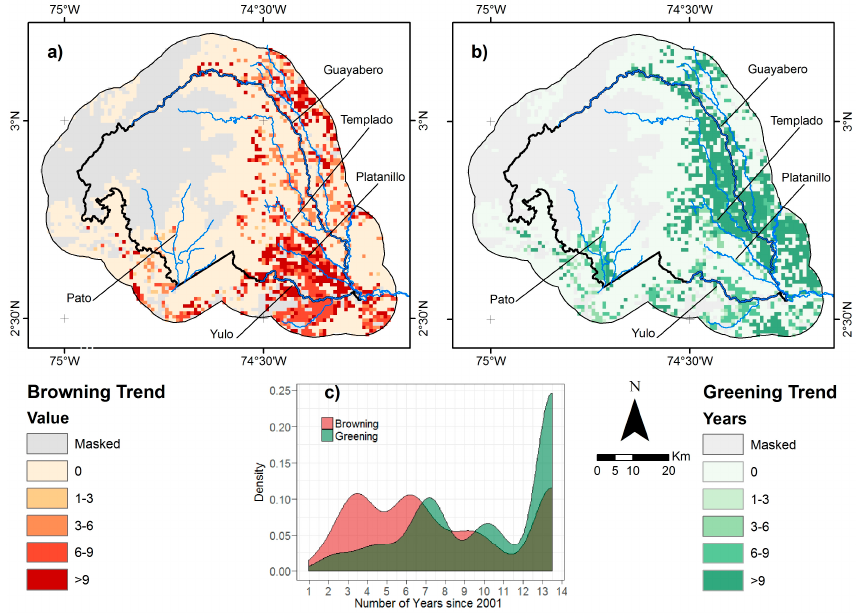
Figure 4. Duration of MAIAC-based ( a ) browning and ( b ) greening trends based on the number of years with significant trends ( α = 0.05); and ( c ) distribution of browning and greening periods across Picachos and its surrounding area.